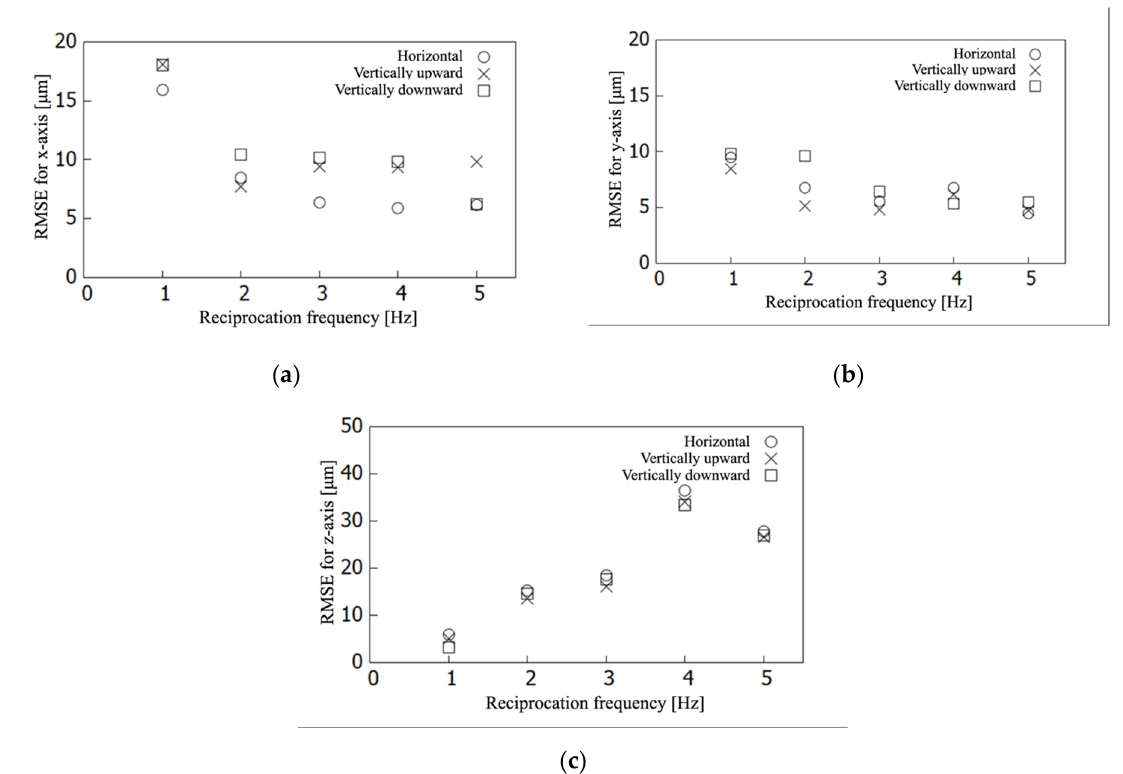
Figure 7. RMSEs of imaging sensor positioning for each horizontal, vertically upward, and vertically downward direction of the device pose. They are given with respect to the device reciprocation frequency for each coordinate-system component of the ( a ) x-axis, ( b ) y-axis, and ( c ) z-axis. Figure 8. RMSEs of imaging sensor positioning with respect to the device reciprocation frequency for each condition with and without the metal placement close to the device.